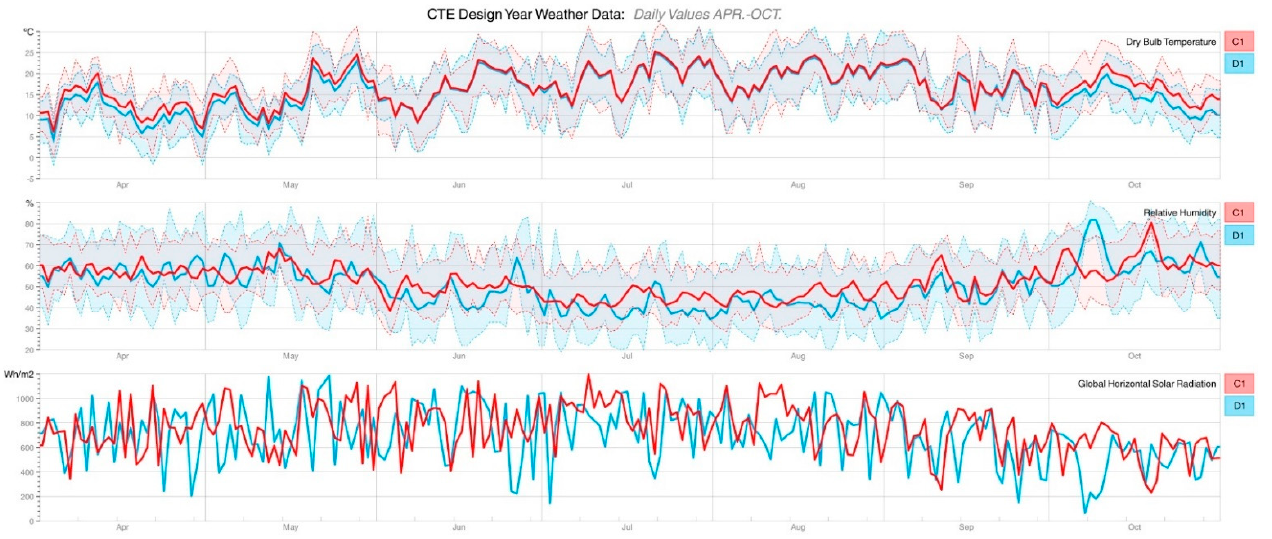
Figure 10. CTE Design Year weather data for climate zones C1 (Bilbao) and D1 (San Sebastian), April to October. Source: authors.